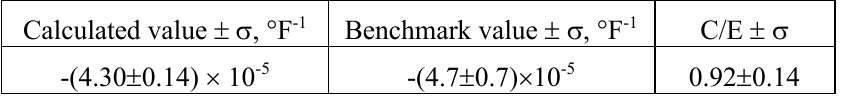
Table V. Fuel temperature